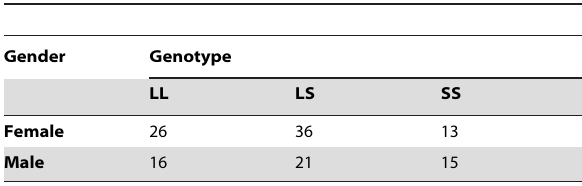
Table 1. The number of female and male participants into each genotype